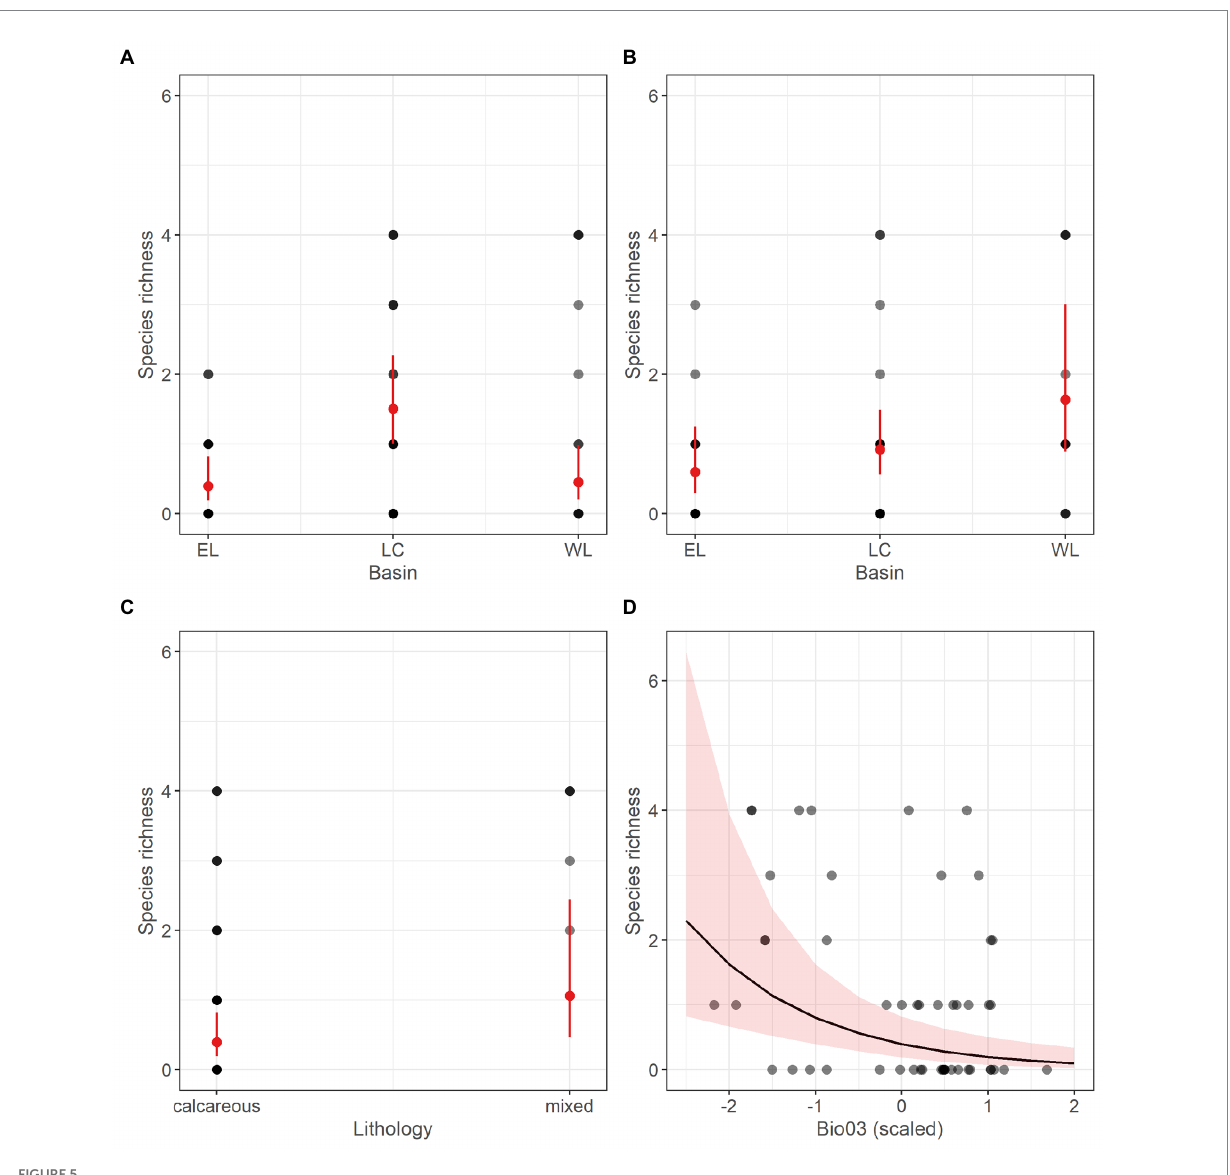
FIGURE 5 Marginal response plots showing the effect of drainage basin (A) , lithology (C) and scaled isothermality (Bio03) values (D) on predicted species richness of stygobitic Harpacticoida, as well as the effect of drainage basin on richness of non-stygobitic Harpacticoida (B) , as resulting from the respective Generalized Linear Models. In (A) , (B) and (C) , red dots and related bars show predicted values and the corresponding 95th percentile confidence interval. In (D) , the black curve corresponds to predicted marginal response with the surrounding shaded area representing the 95th percentile confidence interval. In all the plots, grey-scale dots represent observed values, with darker dots indicating multiple observations with the same richness